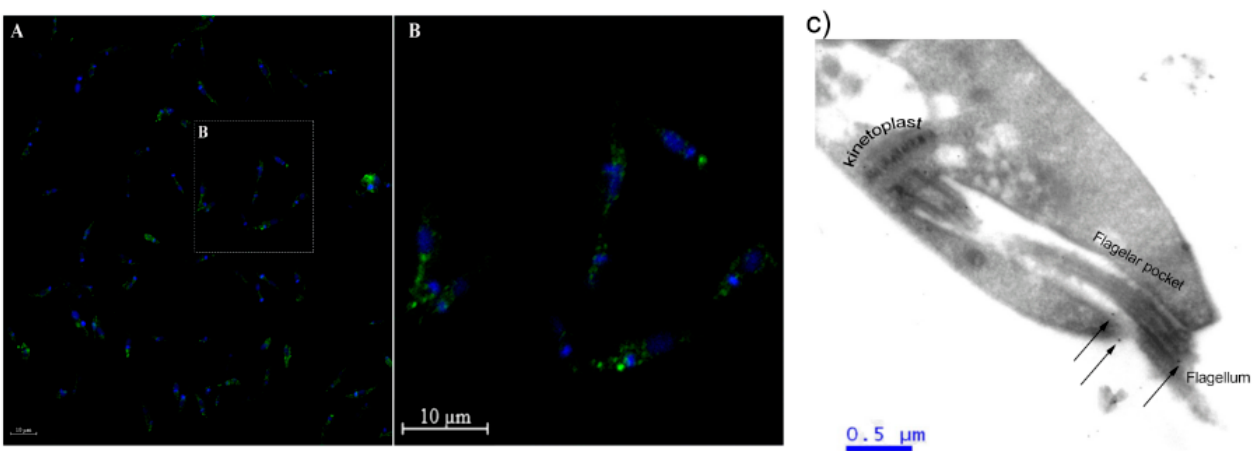
autofluorescence control (black fill). Experiments were performed in triplicate and graphs are rep- resentative of three independent experiments.